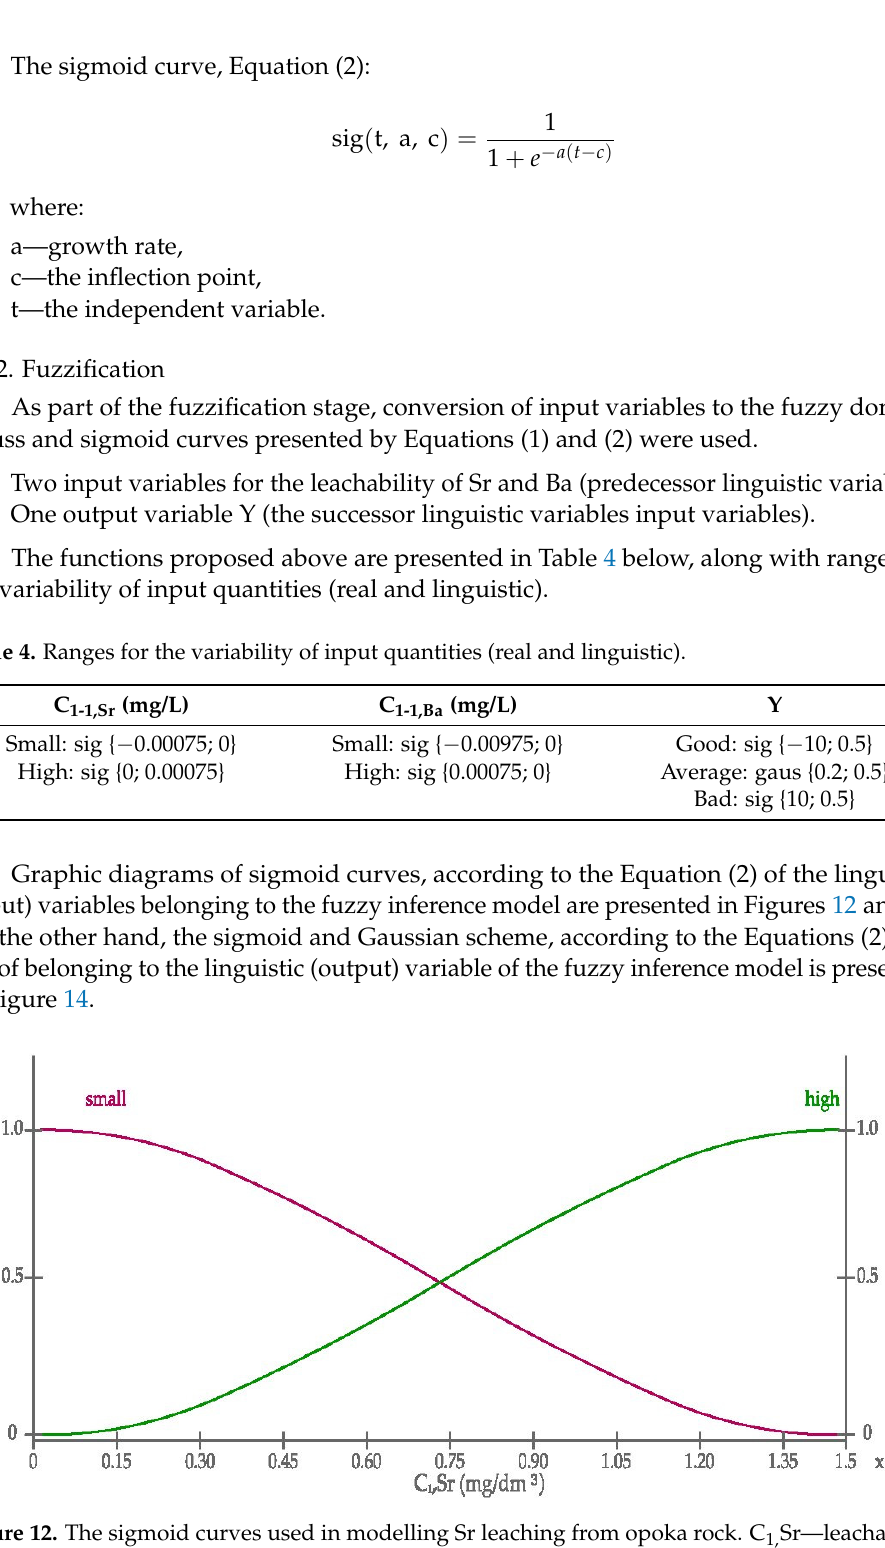
Figure 12. The sigmoid curves used in modelling Sr leaching from opoka rock. C 1, Sr—leachability of Sr.